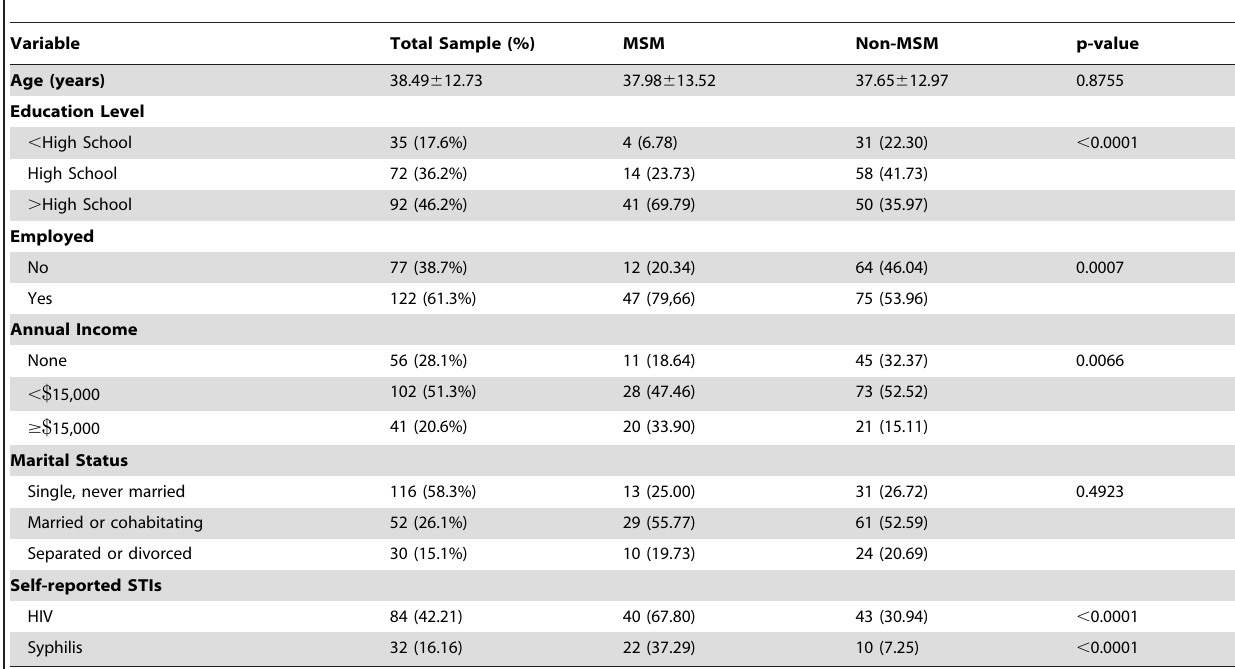
Table 1. Socio-demographic characteristics of a sample of Hispanic men attending an STI clinic in San Juan, Puerto Rico.